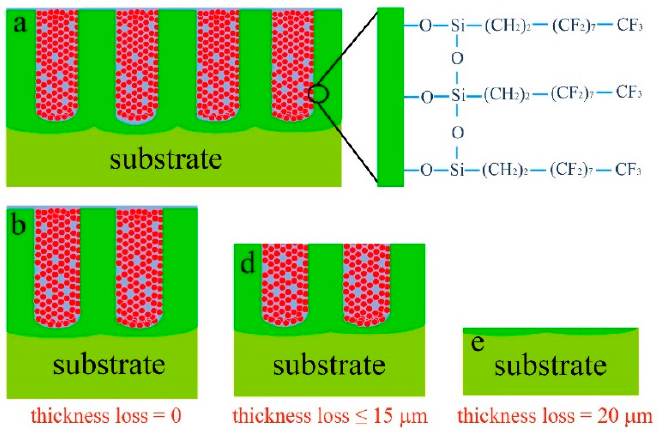
Figure 11. ( a – e ) Mechanism schematic of the robust superhydrophobicity against abrasion.